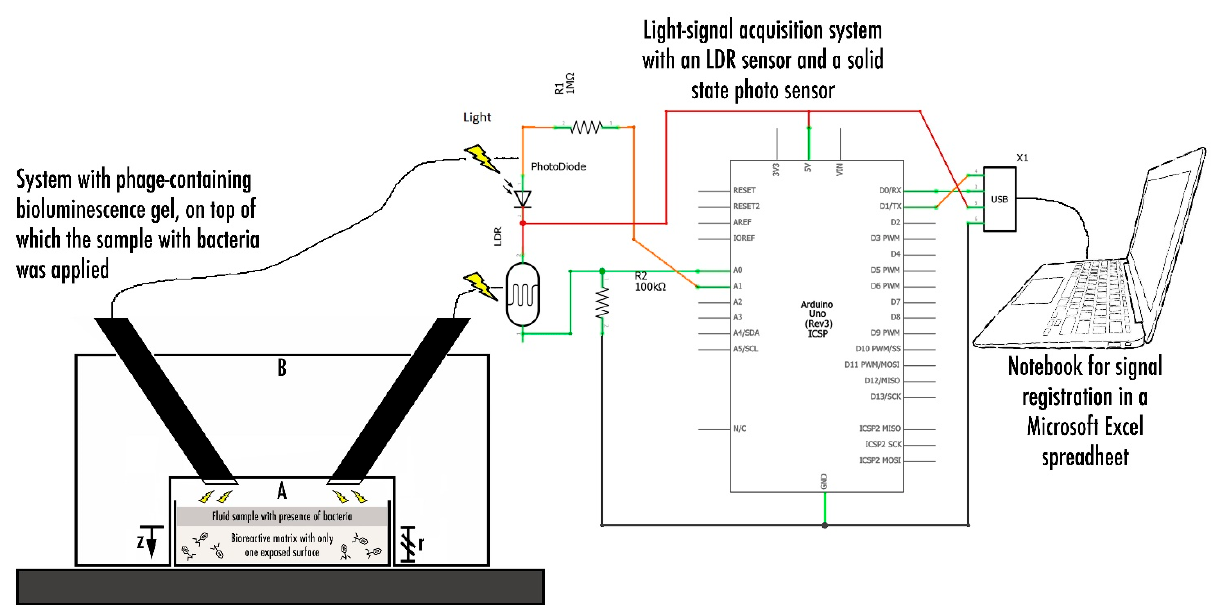
Figure 2. Bio-detection system II, consisting of a small cylindrical equipment machined in rigid white PVC, having approximately 6 cm in height and 6 cm in diameter, divided into a lower part ( A ) where the bio-reactive hydrogel integrating the immobilized phage cocktail, luciferin, luciferase, ADP (adenosine 5 ′ -diphosphate sodium salt), and Mg 2+ is housed, and an upper part (B) housing the light sensors, which was used to cover ( A ). The heart of the system designed consisted of a receptacle for the biopolymeric matrix containing the phage cocktail, above which the light sensors were attached and connected to an Arduino platform, which, in turn, was connected via a USB port to a notebook computer.